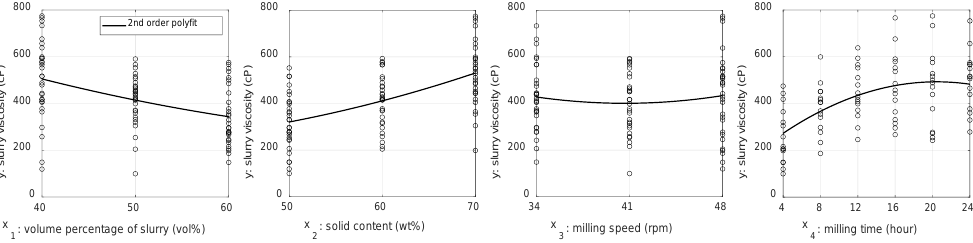
Figure 4. Scatter plots between input and output variables: ( a ) x 1 vs. y ; ( b ) x 2 vs. y ; ( c ) x 3 vs. y ; ( d ) x 4 vs. y .